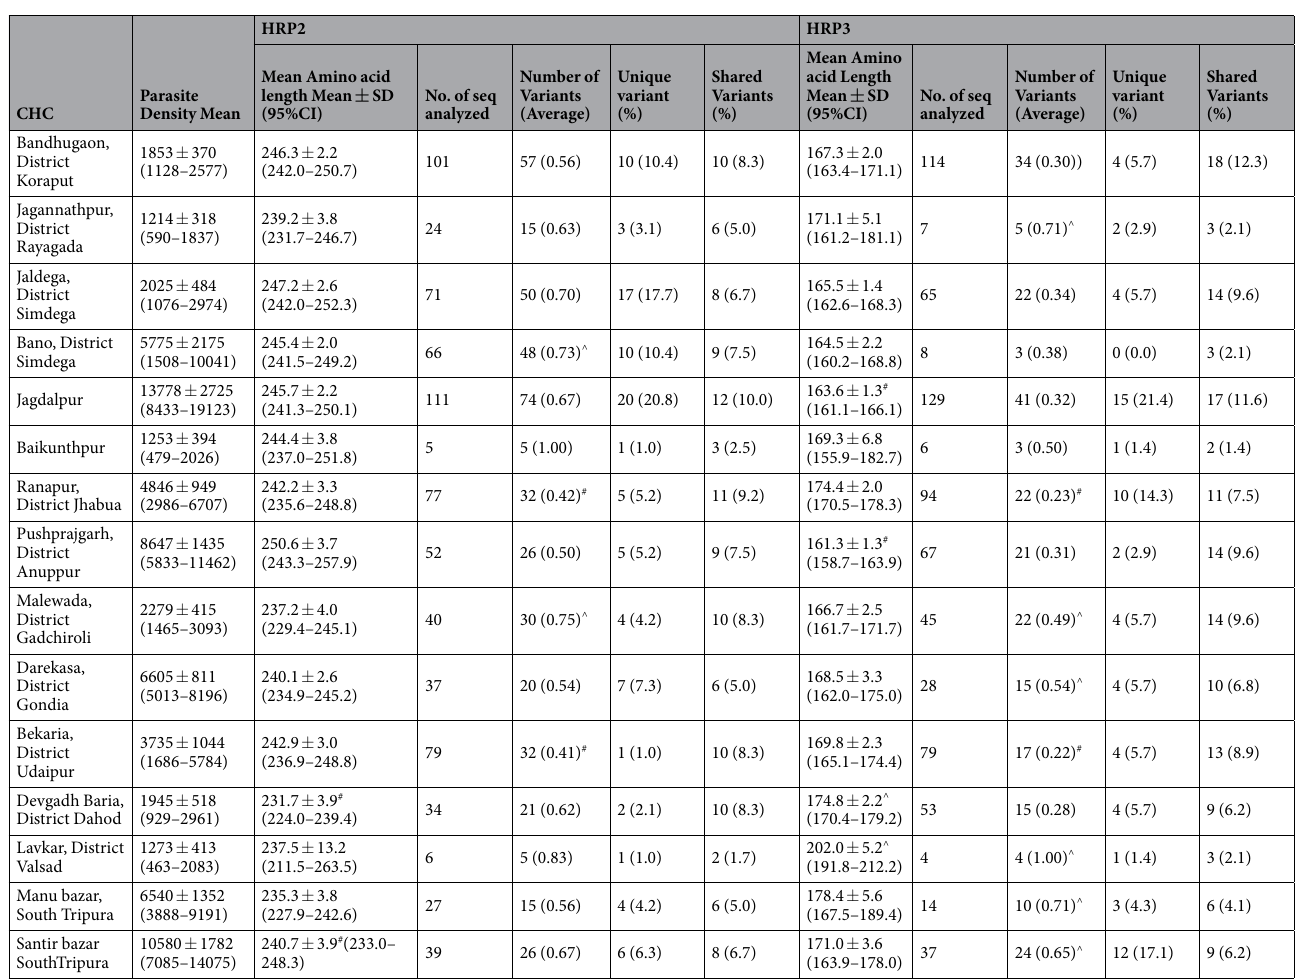
Table 1. Showing the mean parasite density, Amino acid length, number of unique and shared variants of hrp2 and hrp3 genes. ^ The mean is significantly higher than Overall Average; # The mean is significantly lower than Overall mean; Average = average is calculated from number of variants divided by the total number of samples